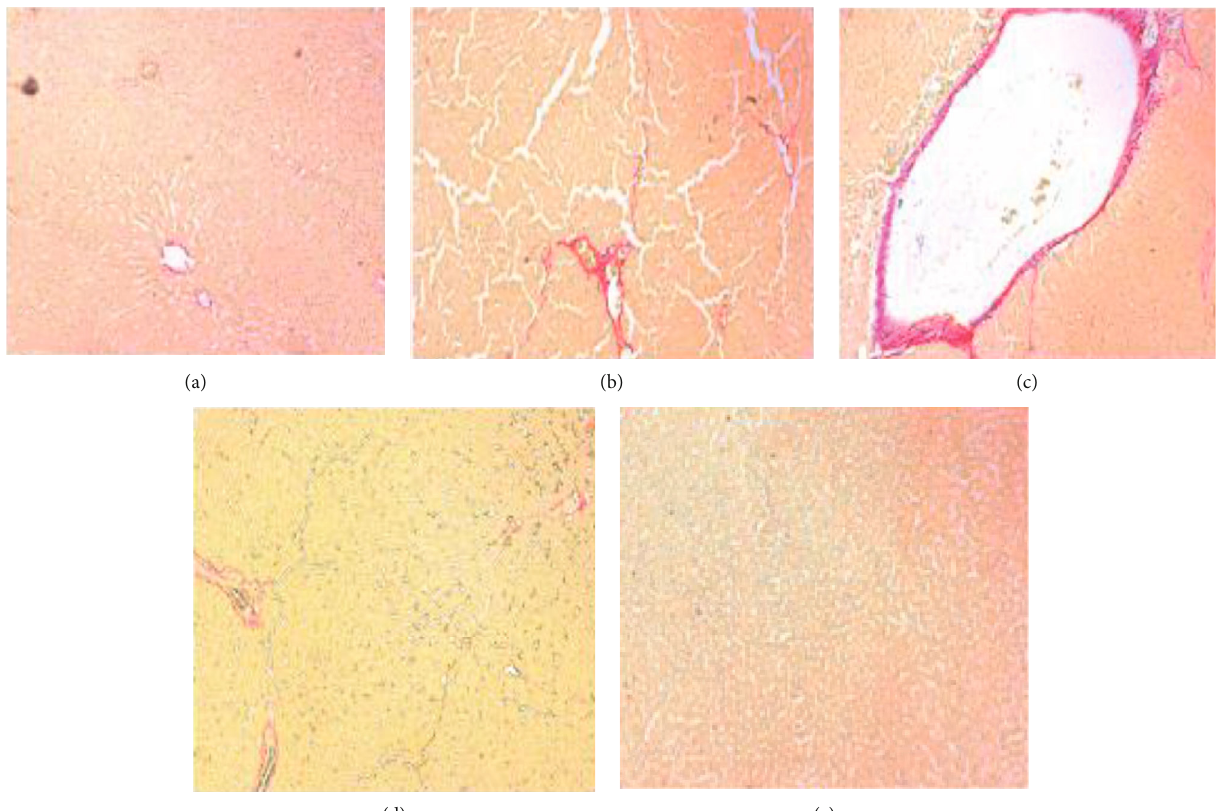
Figure 12: Sirius red staining analysis. Liver tissues showing the normal architecture of hepatocytes (a). DEN-only treated tissues showing signi fi cant fi ber (b, c). 6-Gingerol plus DEN-treated tissue showed much lower collagen fi ber as compared to the DEN-treated group